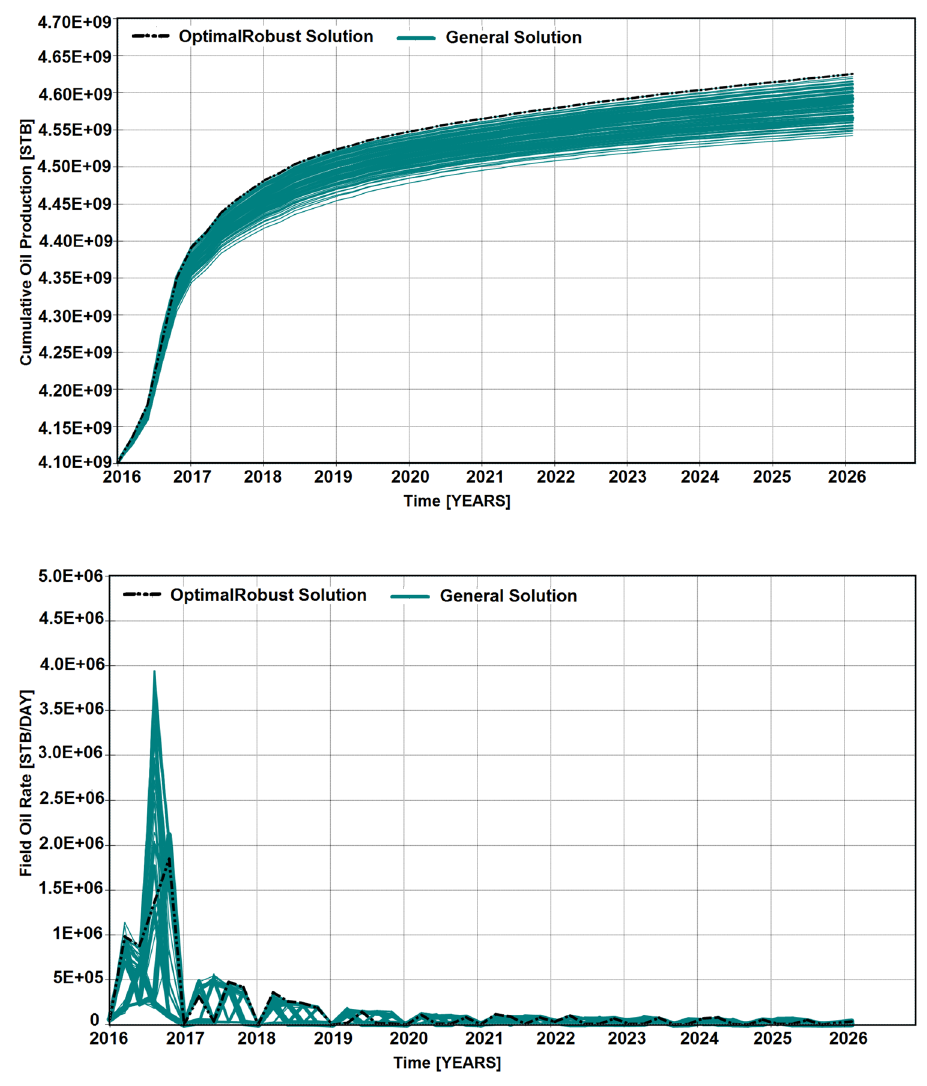
Fig. 11 Effect of geological uncertainty on field cumulative oil production